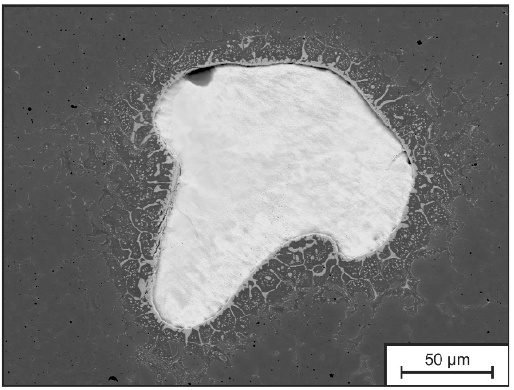
Figure 10. tool steel X36Exemplary SEM picture of incompletely molten W-rich